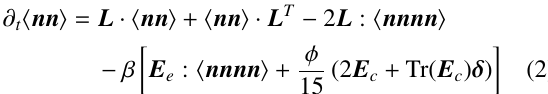
Figure 1. The core insight of the Wyart-Cates theory [1]. For densities just below the frictional jamming point φ J of the upper (frictional) branch of the flow curve is vastly larger than that of the lower (frictionless) branch. Thus any reasonable stress-dependent friction law will create a sigmoidal